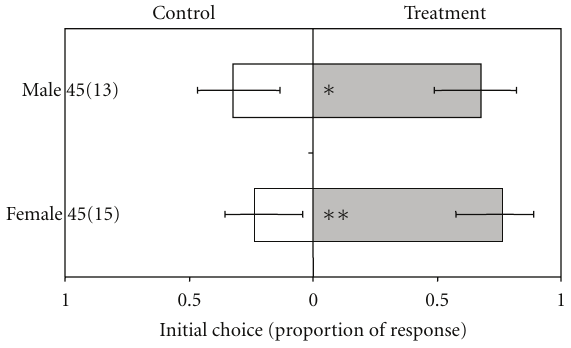
Figure 3: Initial choice (mean ± confidence interval (CI) 95%) of Neomegalotomus parvus males and females to crude extract of fe- male aeration. Analyses of initial choices were carried out by logistic regression and χ 2 Wald test. ∗ indicates P < 0 . 05 and ∗∗ indicates P < 0 . 01. Numbers at left indicate total number of insects tested and numbers in brackets indicate the number of insects that did not make a choice after 5 minutes.